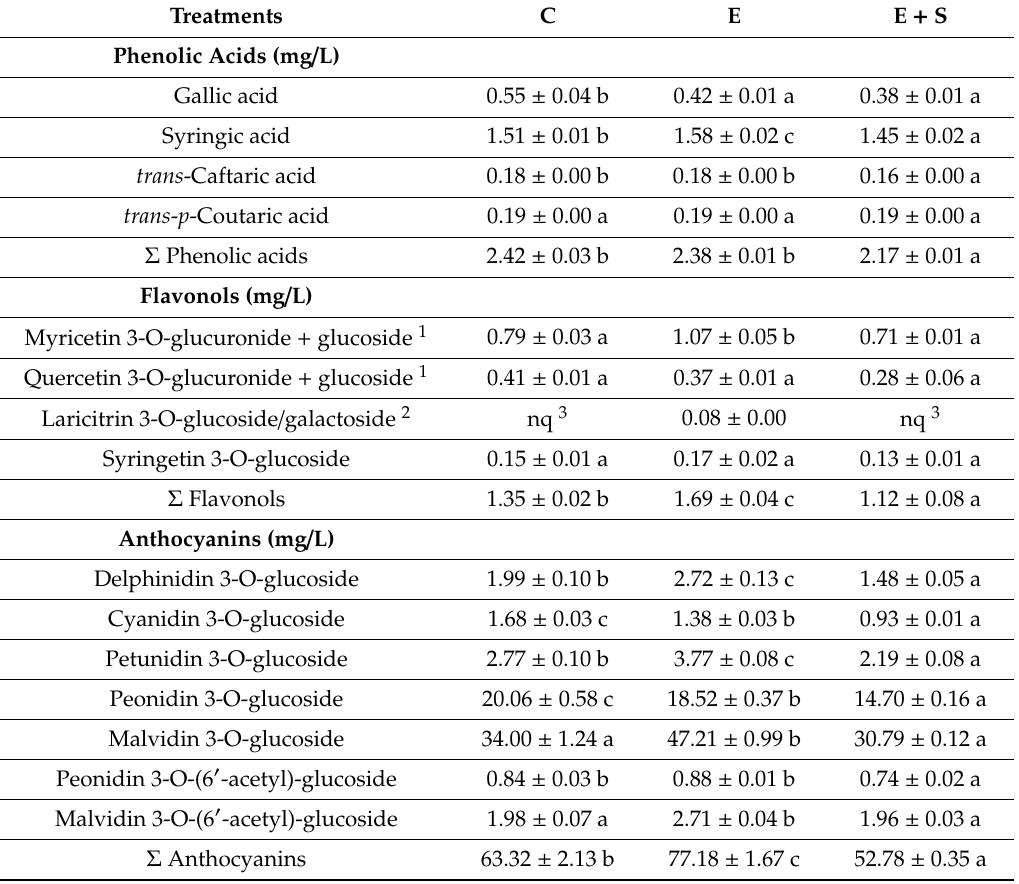
Table 1. Phenolic compounds determined in Bobal grapes on harvest